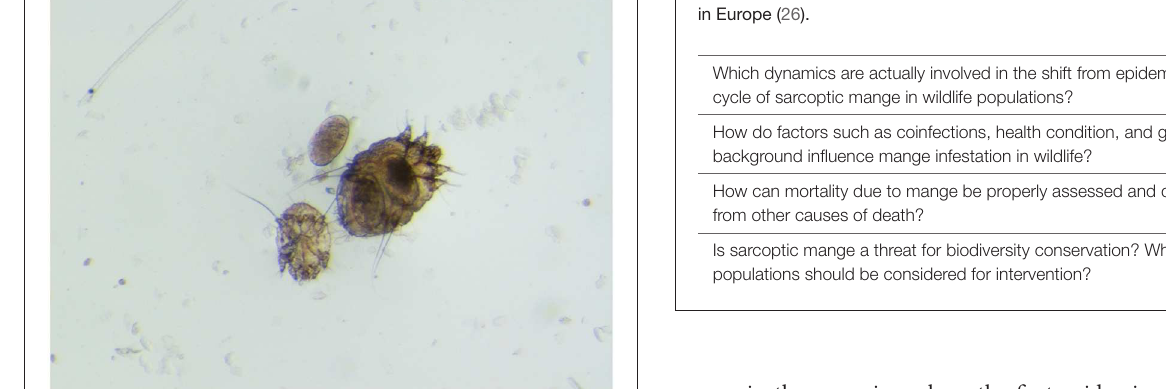
domestic goat, while sporadically to domestic sheep, mouflon ( Ovis aries musimon ), roe deer ( Capreolus capreolus ), and red deer ( Cervus elaphus ) (1,